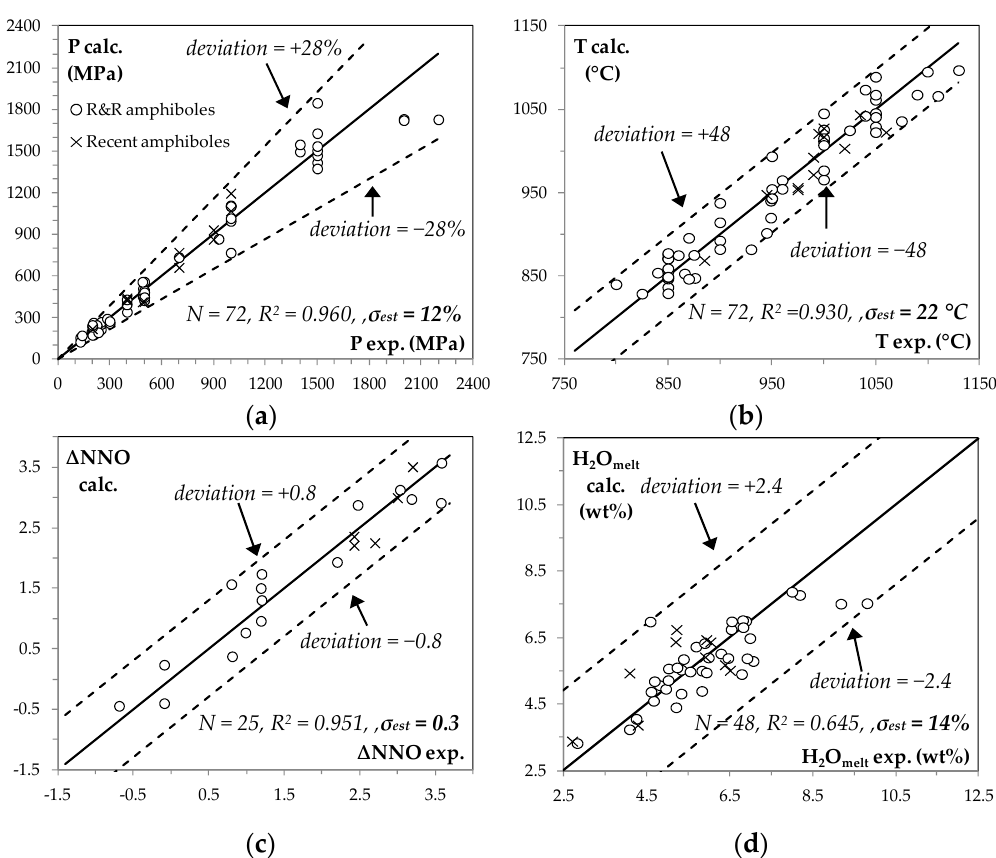
Figure 1. Correlations between calculated (calc. Using Amp-TB2.xlsx) and experimental (exp.) physico-chemical conditions (( a ) P; ( b ) T; ( c ) ∆ NNO; ( d ) H 2 O melt ). R&R indicates amphibole data selected by [10], whereas recent amphiboles represent the newly selected data in this work (see text and Amp-TB2-xlsx). Overall statistic parameters such as sample size (N; i.e., the overall number of data), determination coefficient (R 2 ), and standard error of the estimate ( σ est ) are also reported (note that the % value is σ est calculated on the percentage error). The 1:1 line (solid) is reported in all diagrams. Dashed lines indicate maximum and minimum deviations (errors) shown and expected by the model.